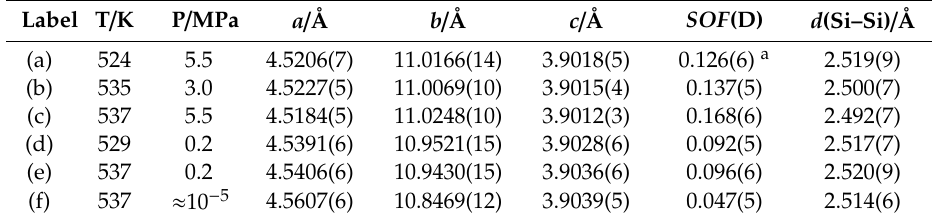
Table 2. Deuterium-poor phases CaSiD x , x = SOF . Labels refer to Figure